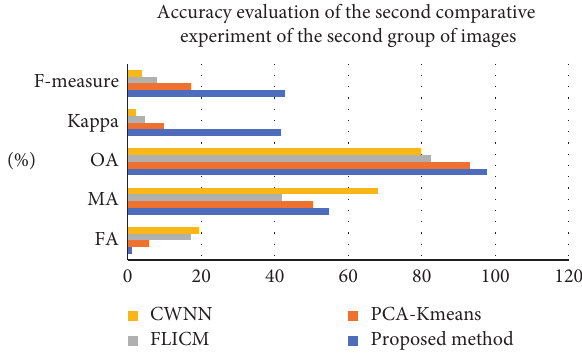
Figure 7: Bar graph of the second group of comparative experimental results of the second group of images. Table 3: Accuracy evaluation of the second comparative experiment of the first group of images.